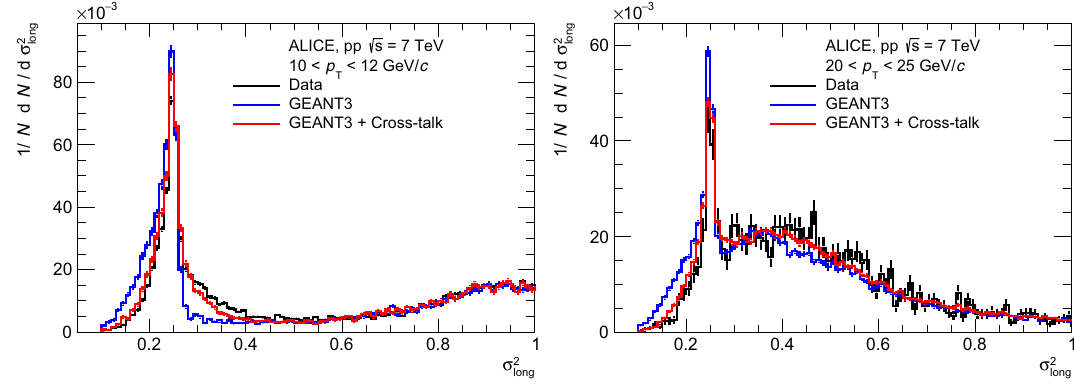
Fig. 3 Distributions of the shower shape parameter σ 2 clusters in data and simulations as used in this analysis. The different panels show different neutral cluster p T intervals. All distributions are normalisedtotheintegral.Dataareshownasblackhistogramsandsimu-